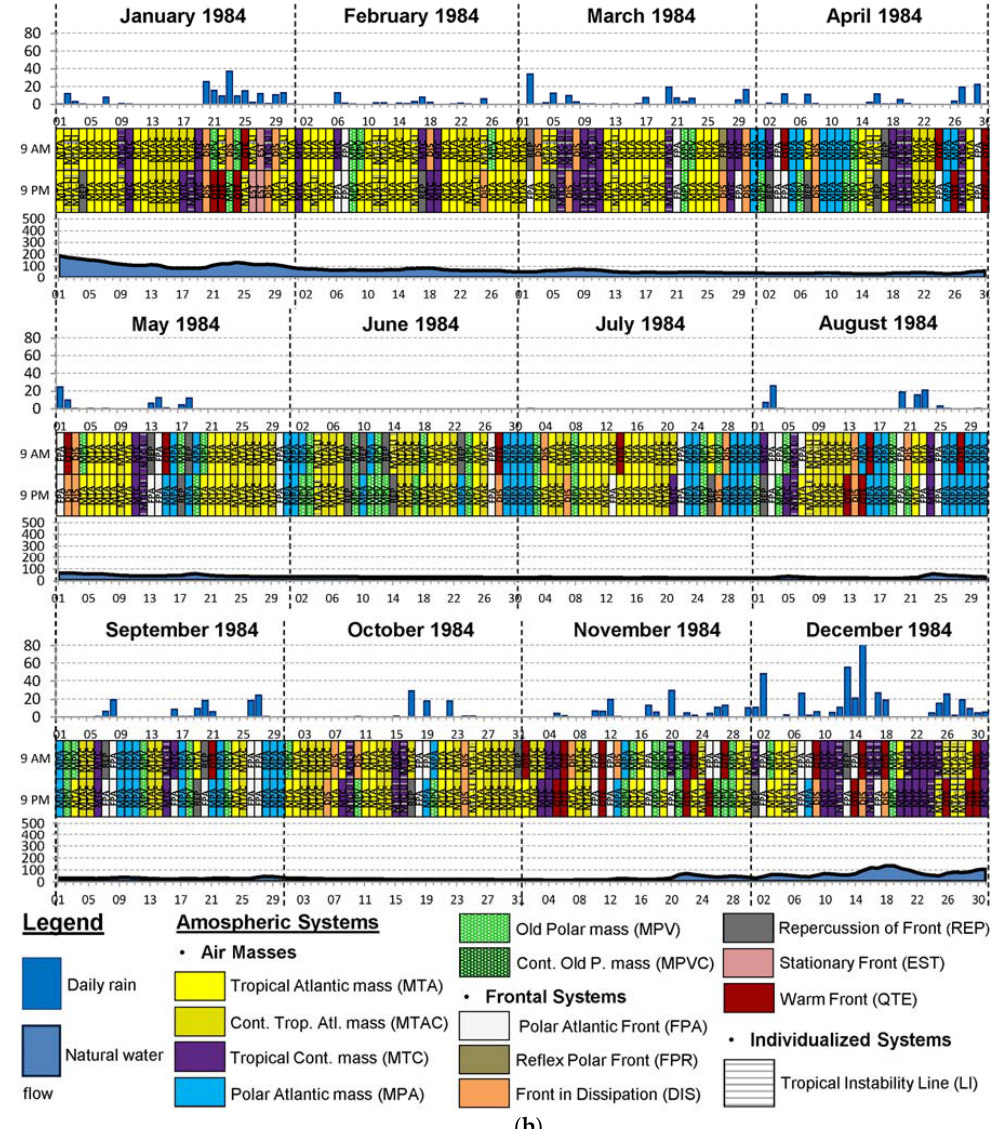
Figure 8. Rhythm of the atmospheric systems associated with rainfall and natural water flow in the year ( a ) 1983; ( b ) 1984. year ( a ) 1983; ( b )